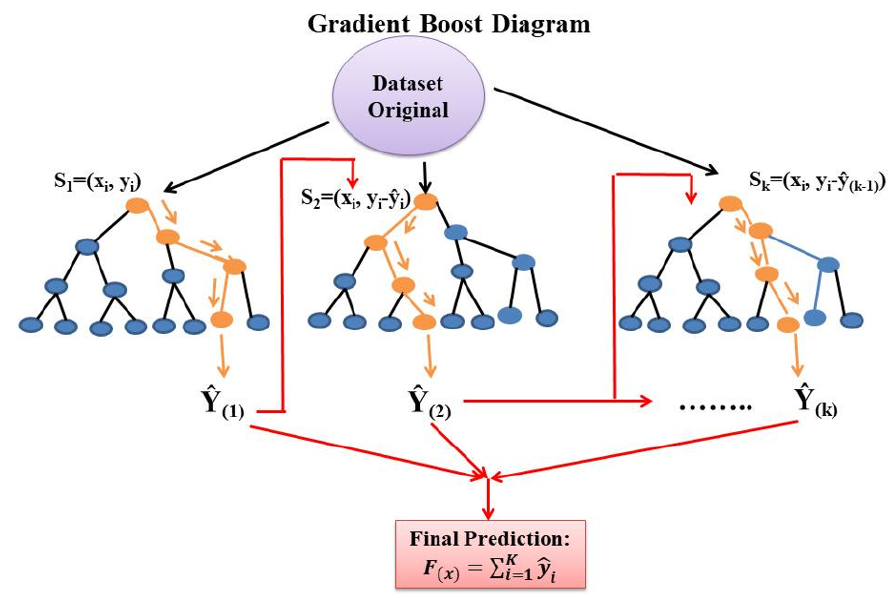
Figure 3. Schematic diagram of Gradient Boost.